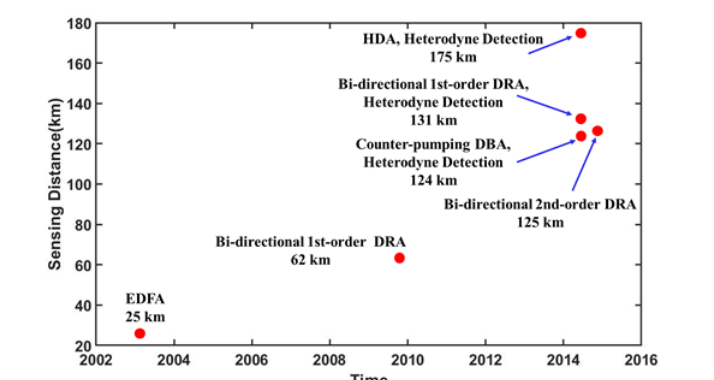
Fig. 2 Development of long-distance Ф